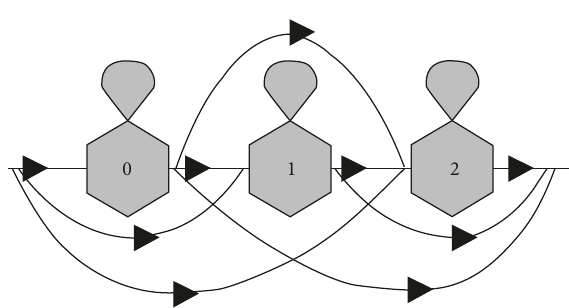
Figure 3: HMM across n − 1